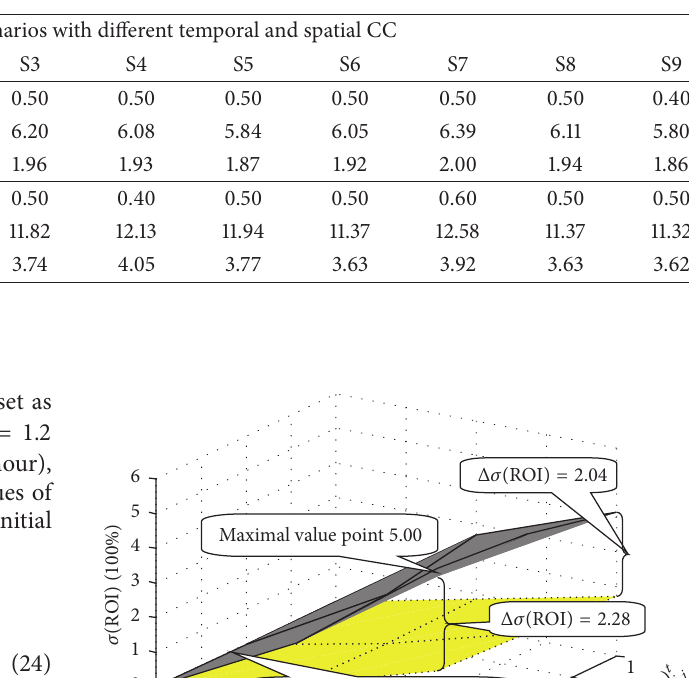
Table 1: The resultant mean ROI values of each candidate project with respect to different temporal and spatial CC and population growing factor.